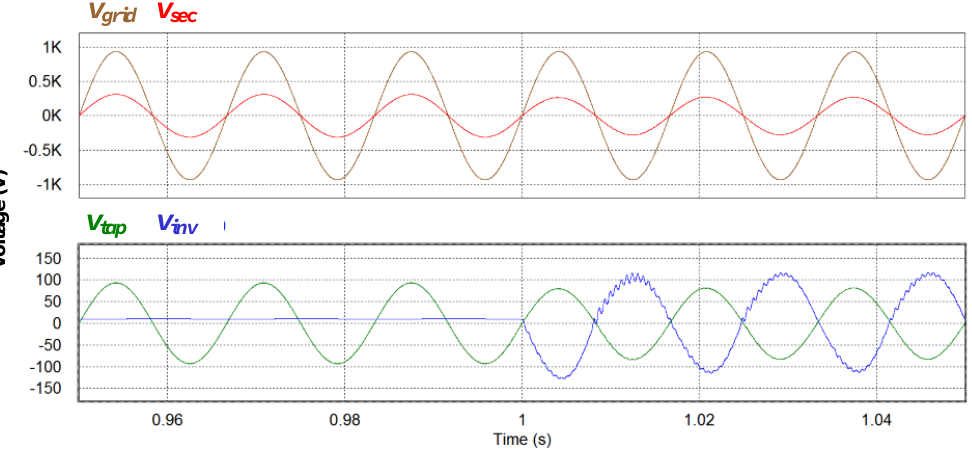
Figure 9. Simulation results of buck mode operation.